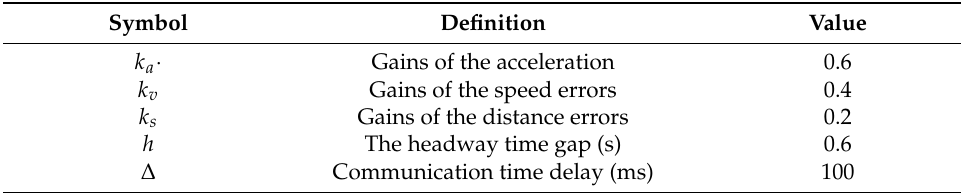
Table 2. Parameters value of the CACC controller.